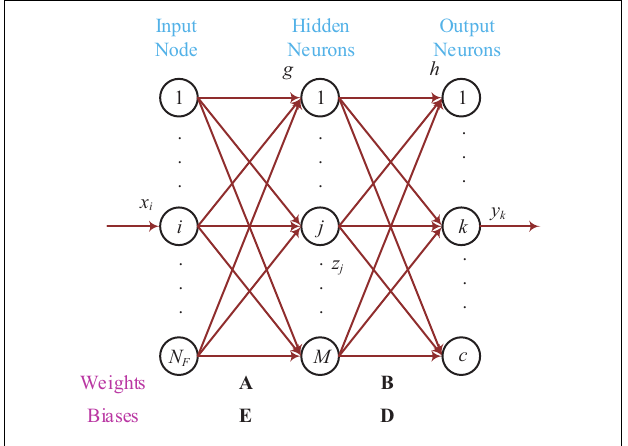
FIGURE 4 | Diagram of one-hidden-layer